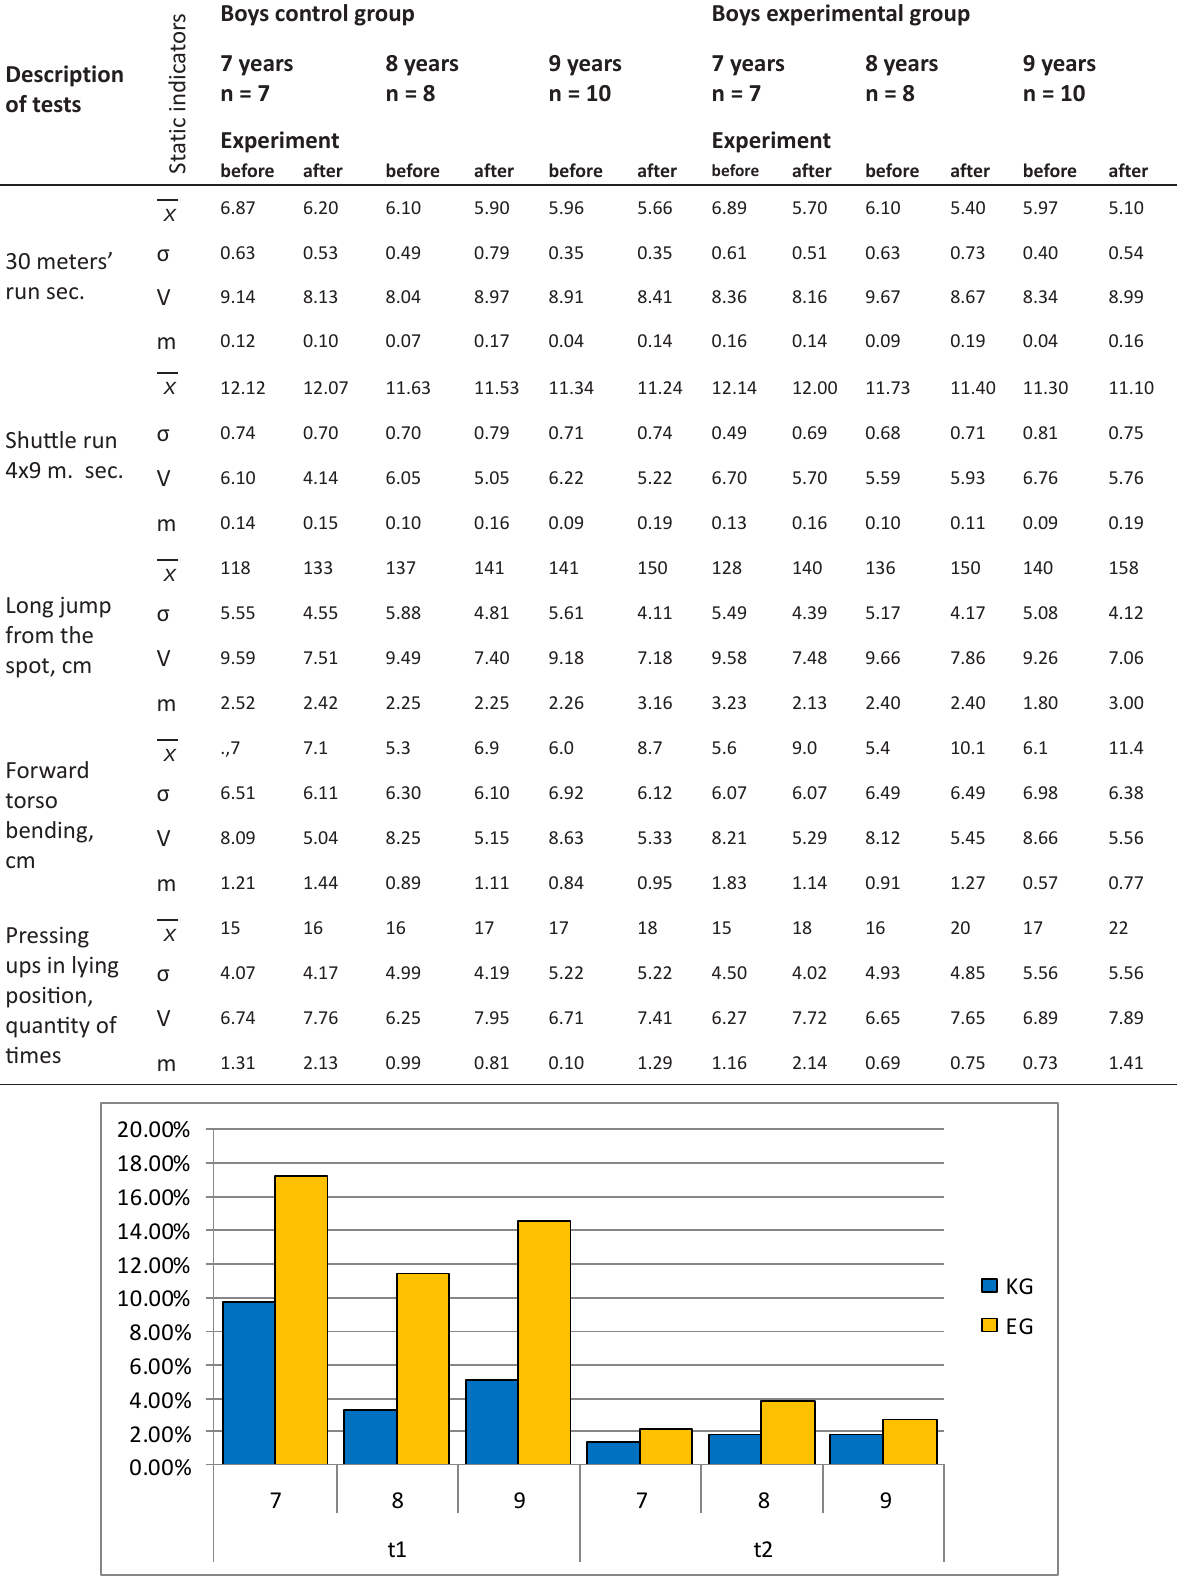
Fig.1. Percentage increment of physical qualities’ indicators in control (CG) and experimental (EG) groups. 7, 8, 9 – age in years, L – Long jump from the spot (cm); M – Forward torso bending from standing position (cm), CG – control group, EG – experimental group; t1 – 30 meters’ run (sec.); t2 – Shuttle run 4х9 m (sec.); A – Pressing ups in lying position (quantity of